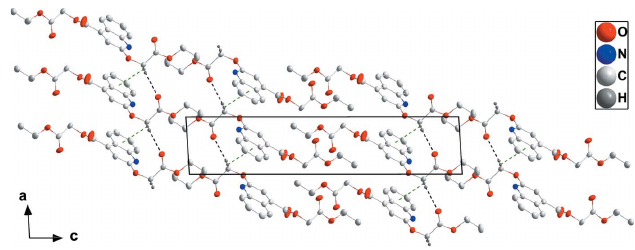
Figure 2 A portion of the hydrogen-bonded chain viewed along the b -axis direction. C—H (cid:3)(cid:3)(cid:3) O hydrogen bonds and C—H (cid:3)(cid:3)(cid:3) (cid:2) (ring) interactions are shown, respectively, by black and green dashed lines.